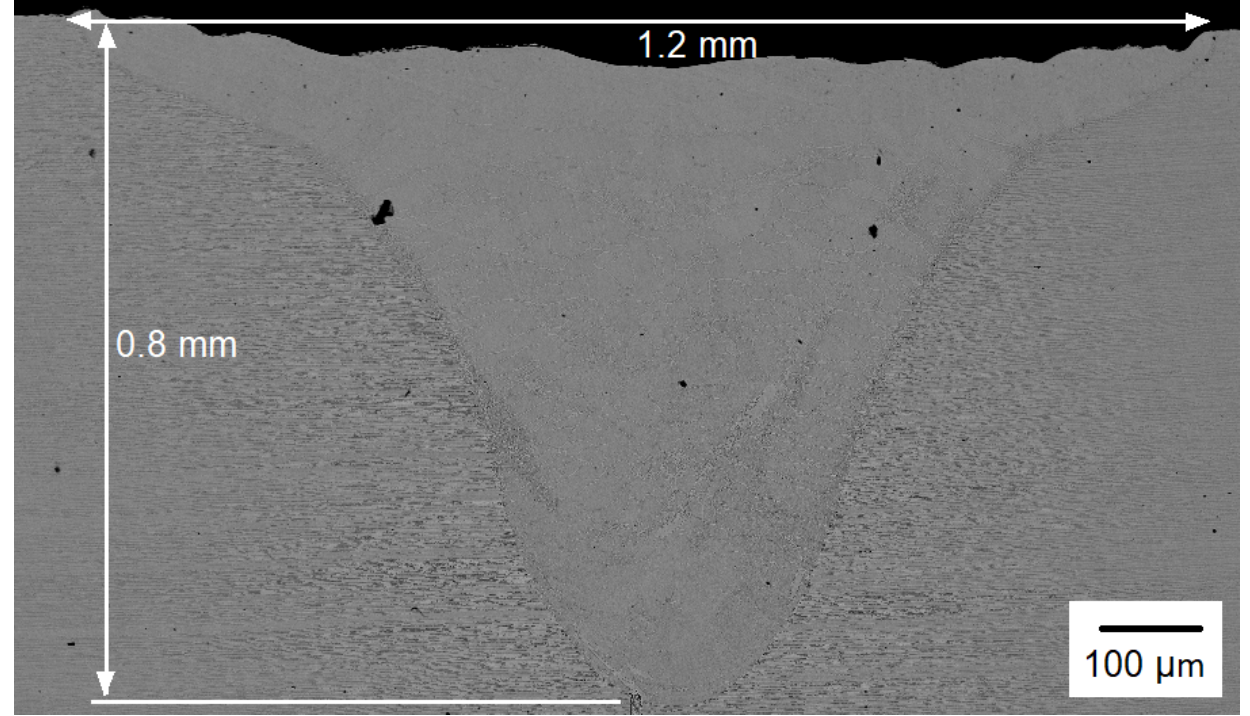
Figure 3. SEM micrograph of the entire weld bead.